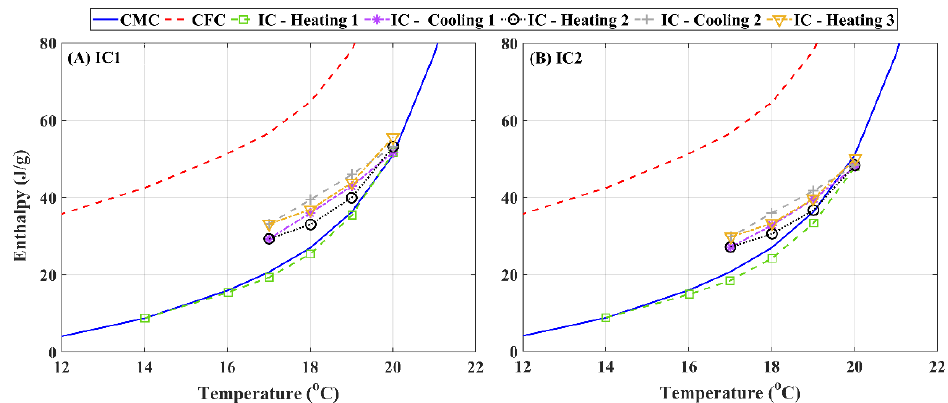
Figure 5. Temperature–enthalpy curves of ( A ) IC1 and ( B ) IC2 tests superimposed on CMC and CFC curves.